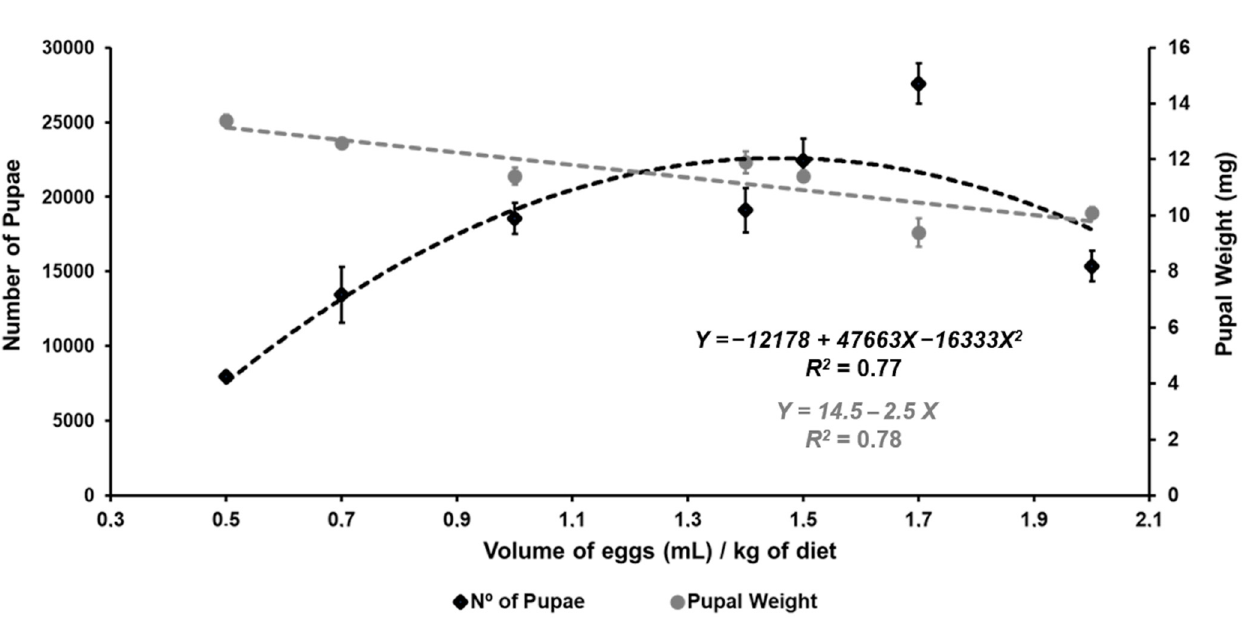
Figure 3. Regression lines for the number of pupae and pupal weight obtained from a diet with corn flour and carrageenan (CENA’s diet) at different egg-seeding densities. Error bars represent the standard errors of means.